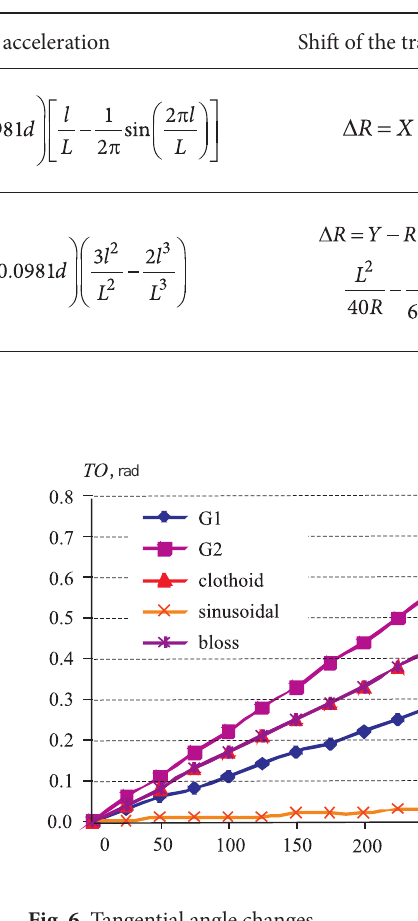
Fig. 5. Curvature changes Fig. 6. Tangential angle changes